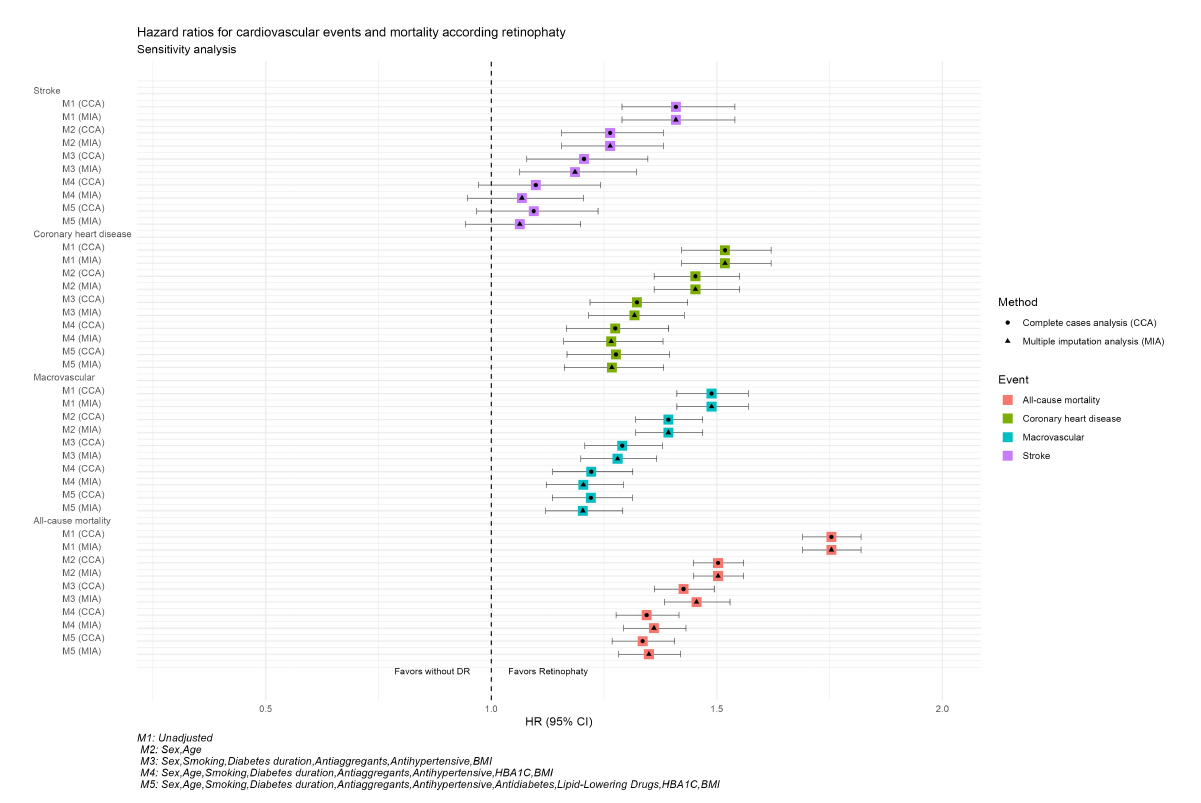
FIGURE3 Hazard ratios for cardiovascular events and mortality according retinopathy Sensitivity analysis. M1, unadjusted; M2, sex, age; M3, sex, smoking, diabetes, antiaggregants, antihypertensive, BMI; M4, sex, age, smoking, diabetes, duration, antiaggregants, antihypertensive, HBA1C, BMI; M5, age, smoking, diabetes, duration, antiaggregants, antihypertensive, antidiabetes, libid-lowering drugs, HBA1C,